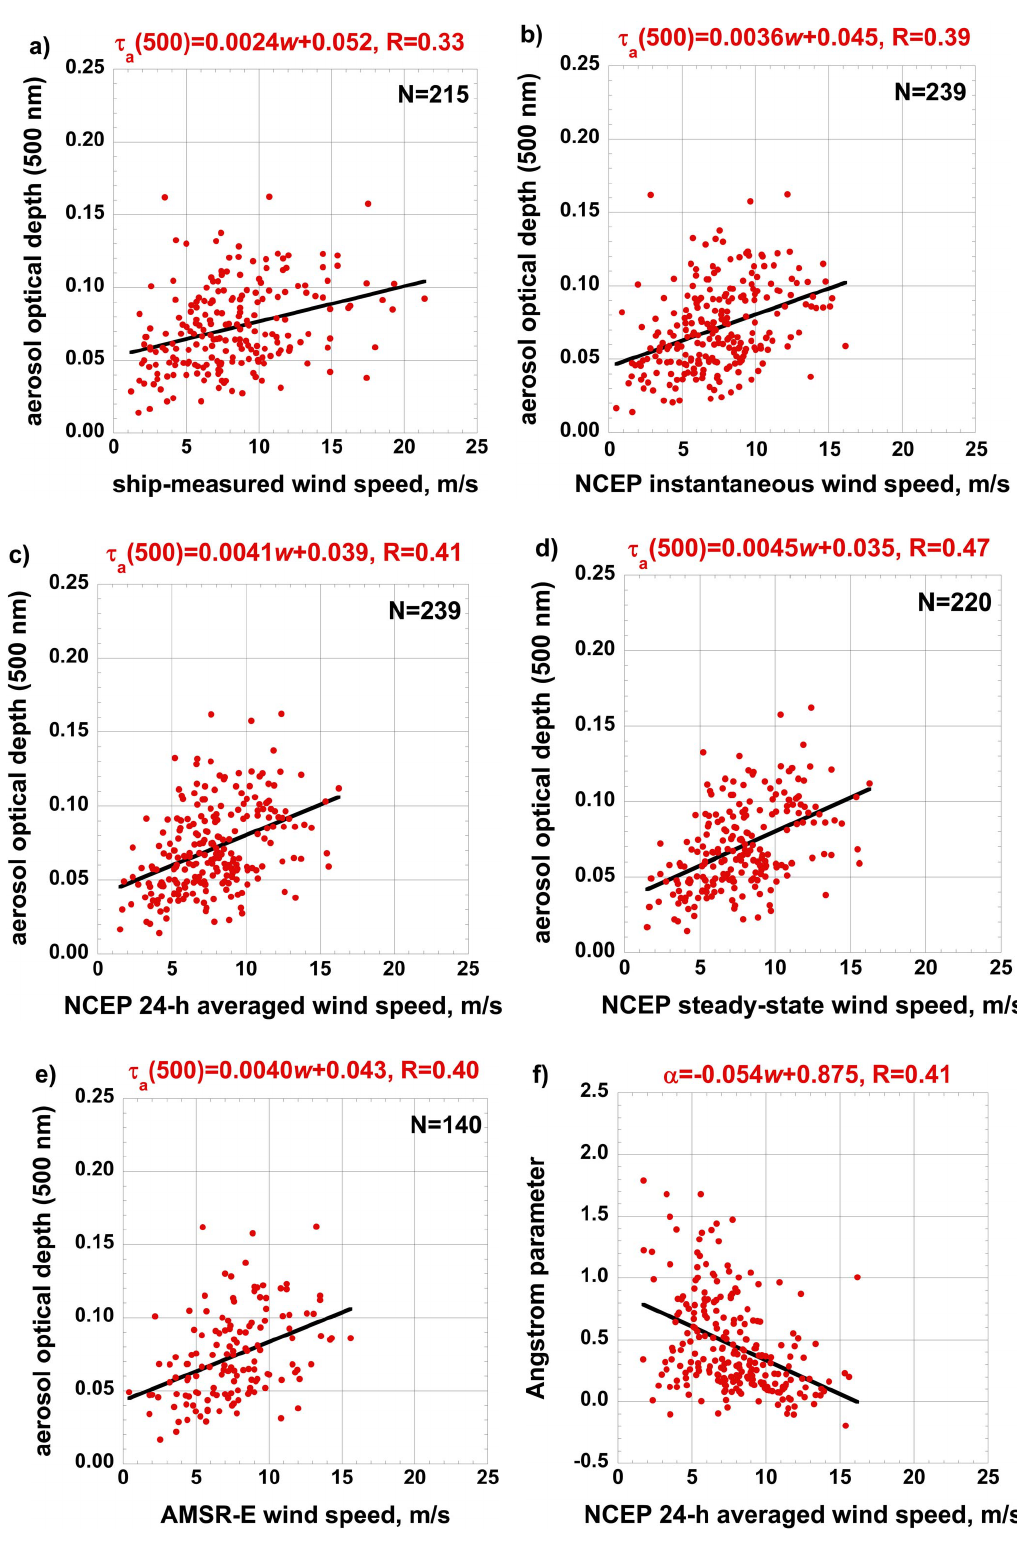
Fig. 5. Scattergrams of daily averaged AOD at 500nm (a–e) and Angstrom parameter (f) versus the surface wind